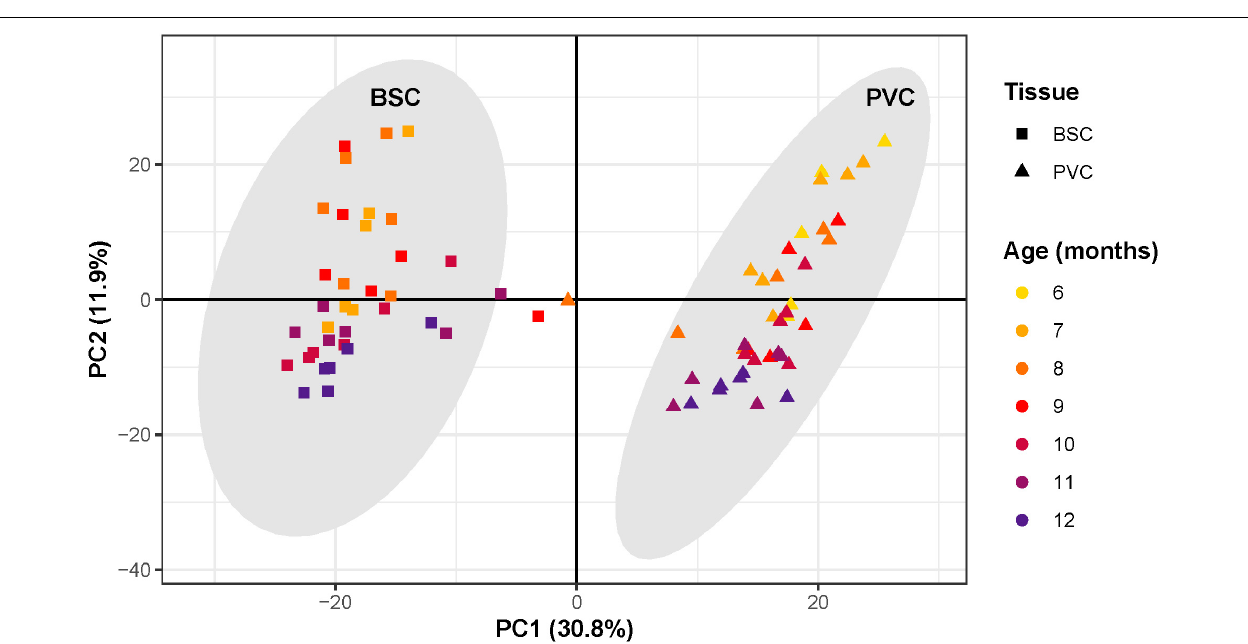
FIGURE 3 | Principal component analysis of RNAseq samples. Scatter plot of principal component analysis with first principal component along the x -axis and second principal component along the y -axis. Each point corresponds to an individual sample. The shape of each point corresponds to sample tissue type, square for Buccal S Cluster (BCS) and triangles for Pleural Ventral Caudal cluster (PVC). Point color corresponds to age, from 6 to 12 months. Samples segregate along the first principal component according to tissue, forming two distinct clusters. Gray ovals around each cluster represent the cluster 99.7% confidence intervals. Three samples outside the tissue-cluster confidence intervals were considered outliers. Samples segregate roughly according to chronological age along the second principal